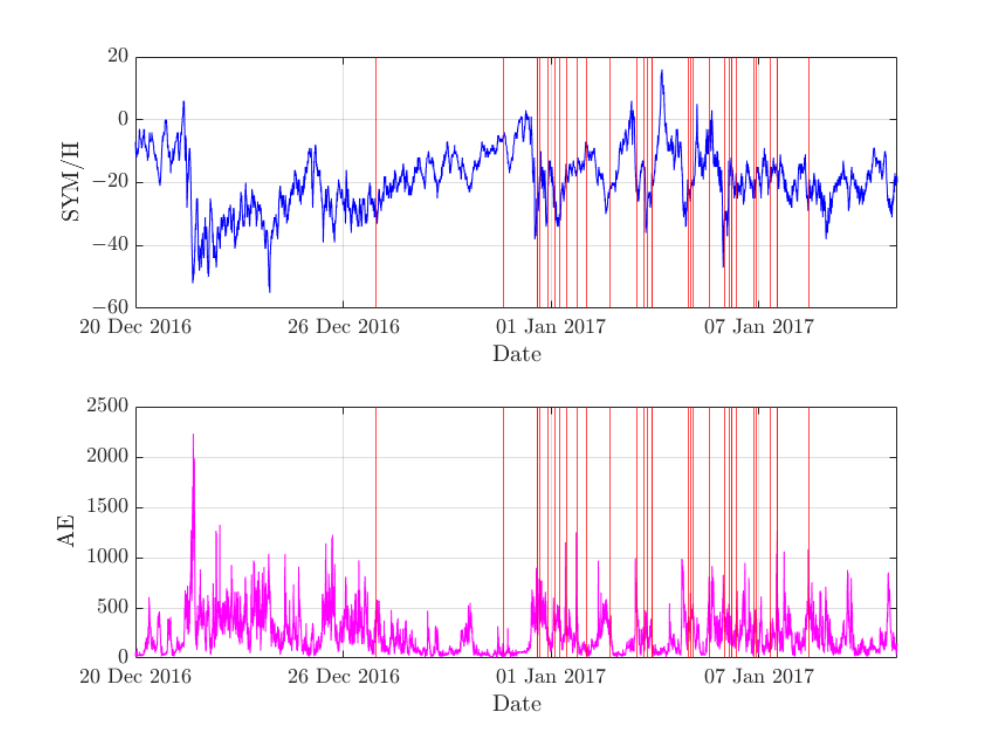
Figure 1. Geomagnetic activity during end of December 2016–beginning of January 2017. Upper plot demonstrates SYM/H index behavior, lower plot—AE-index. TUS event registrations are shown by red vertical